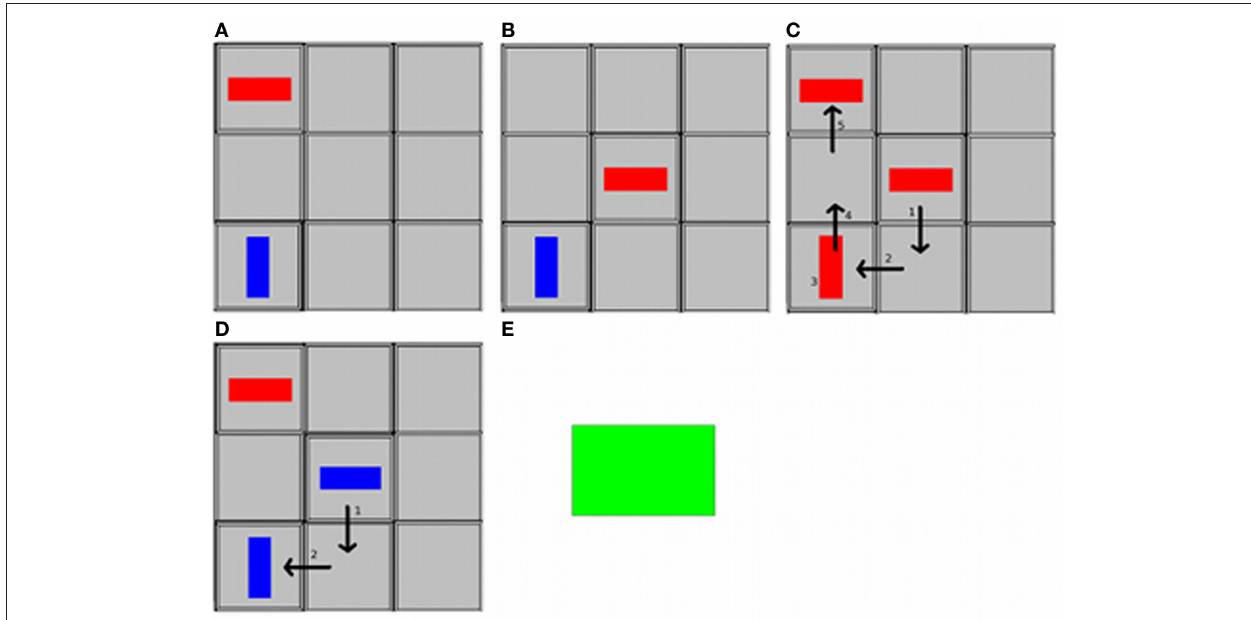
Figure 2 | The TCg playing board and tokens and sequence of events in a trial, viewed from the Sender’s perspective. The Sender’s token is in red, the Receiver’s token is in blue. (A) The Sender sees the goal configuration. The Receiver does not see the goal configuration. (B) The